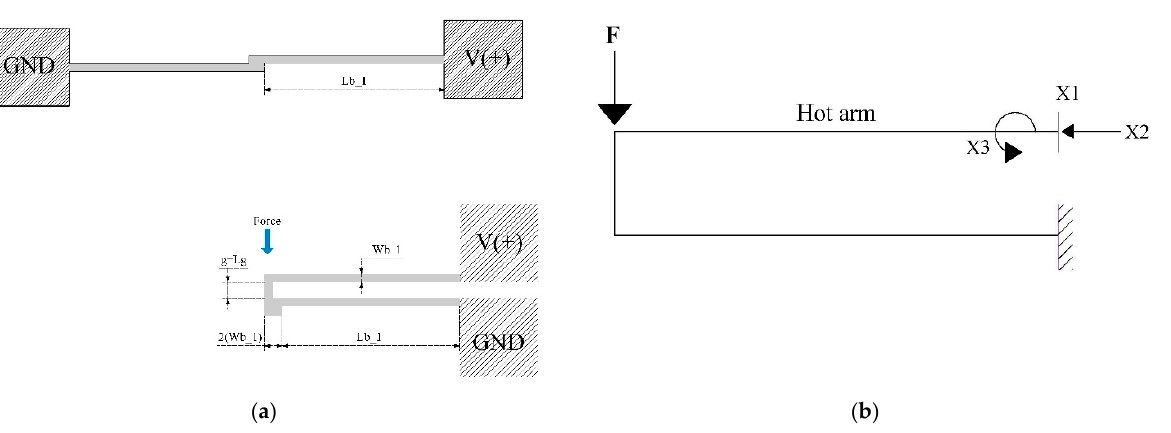
Figure 3. ( a ) Microactuator of two beams (MTB) transformed as a U-shaped beam microactuator, and ( b ) simplified rigid frame of the thermal actuator with three redundant elements.